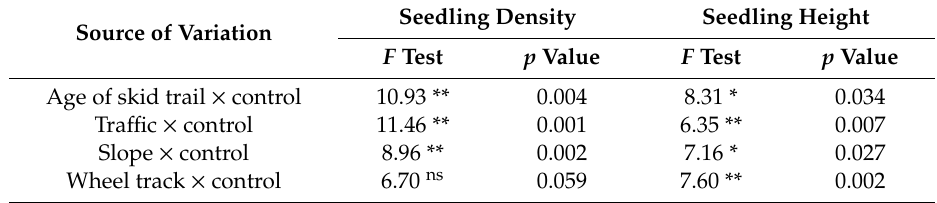
Table 9. Results of ANOVA applied on density and height of seedlings at di ff erent treatments.